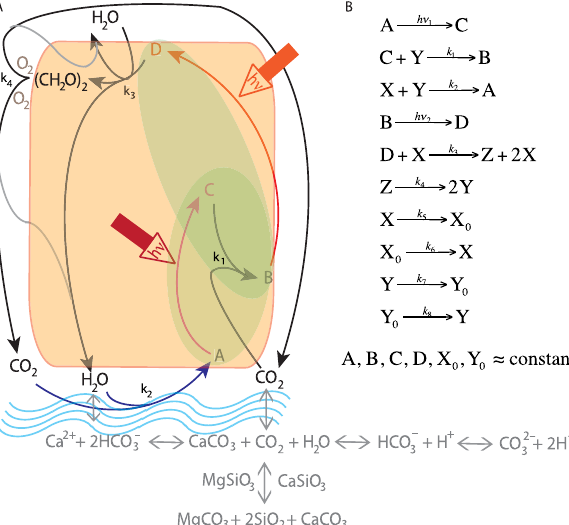
Figure 5. The Glaciator . Representation of the reactions taking place in the closed system emphasizing the analogy between photochemical reactions and photosynthesis, and their generation of a high-energy intermediate (CH 2 O) 2 . The green shade covers the photosynthetic steps and the orange shade covers the steps in the biomass. Under conditions where A, B, C and D are approximately constant, the changes in the concentrations of the composition variable X = H 2 O, Y = CO 2 and Z = CH 2 O are determined by the reactions of k the Coimbrator and, additionally, by X